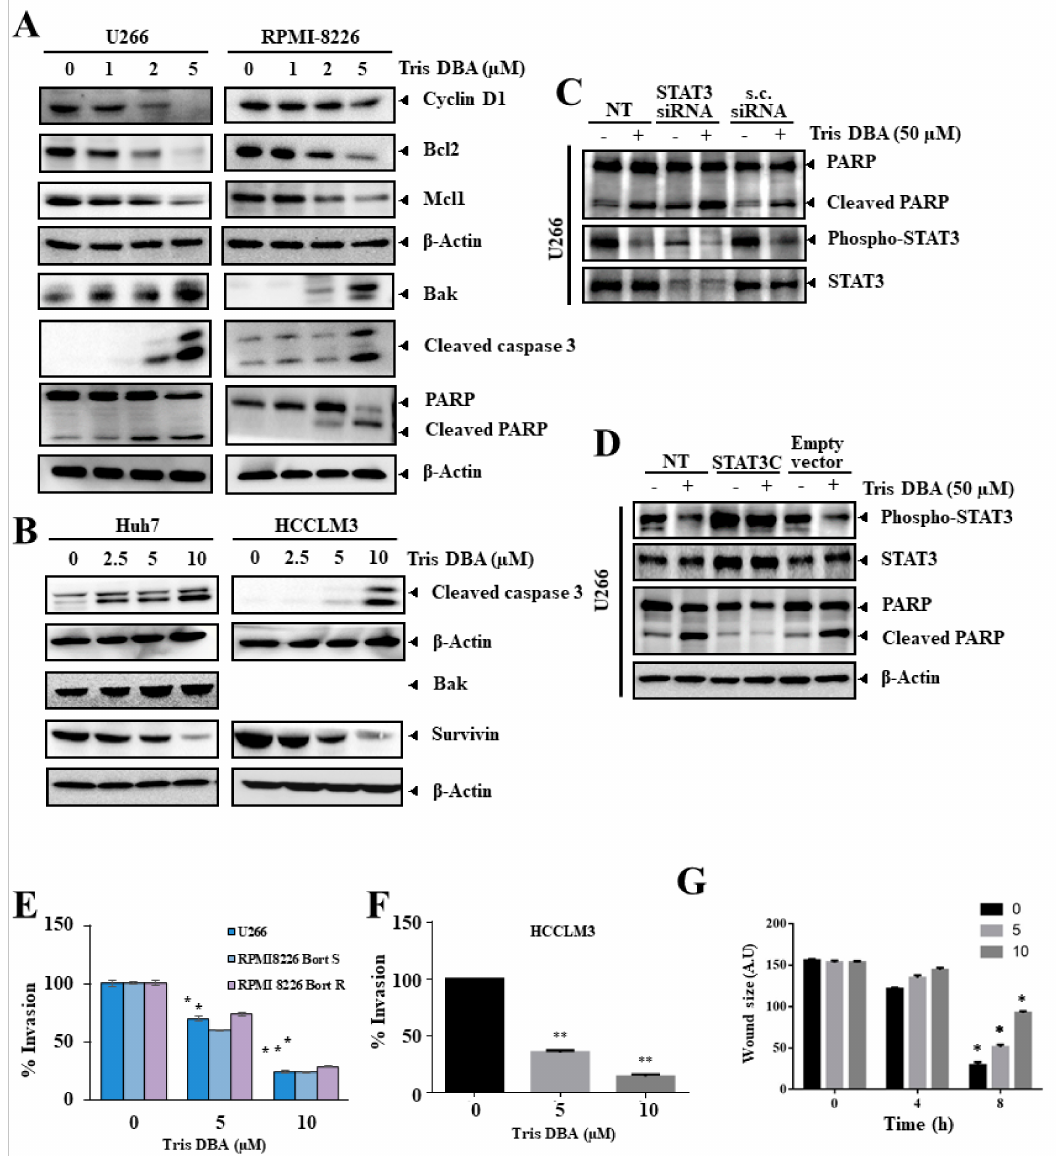
Figure 5. Tris DBA downmodulates STAT3 targeted gene expression and induces apoptosis. ( A , B ) MM (U266, and RPMI- 8226) and HCC (Huh7, and HCCLM3) cells were incubated with given doses of Tris DBA and cell lysates were analyzed for the expression of cyclin D1, Bcl2, Mcl1, Bak, caspase 3, survivin, and PARP expression. ( C ) U266 cells were transfected with scrambled or STAT3 siRNA (100 nM). After 48 h, cells were treated with Tris DBA 50 µ M and the western blotting was done. ( D ) Cells were transfected with STAT3C or empty vector (300 ng). After 48 h, cells were treated with Tris DBA 50 µ M and western blot analysis for various proteins was carried out. ( E ) Tris DBA suppresses cancer cell invasion and migration. MM (U226, and RPMI-8226) and HCCLM3 cells were incubated with different doses of Tris DBA and seeded in invasion chambers in serum-free media. The lower chamber was filled with FBS supplemented media. After the incubation with the suggested time point, the cells on the upper side were stained with crystal violet to visualize and quantify them. ( F ) HCCLM3 cells were seeded into a culture vessel that has a culture-insert and the removal of this insert creates the cell-free space. The movement of the cell is visualized and measured either on treatment with Tris DBA or untreated samples. ( G ) HCCLM3 cells were cultured in a culture dish, a cell-free space (wound) is created and cells were treated with Tris DBA. Thereafter, the antimigratory effect of Tris DBA was examined at different time-points. Bars indicate standard deviation; n = 3; * p < 0.05, ** p < 0.01 versus no